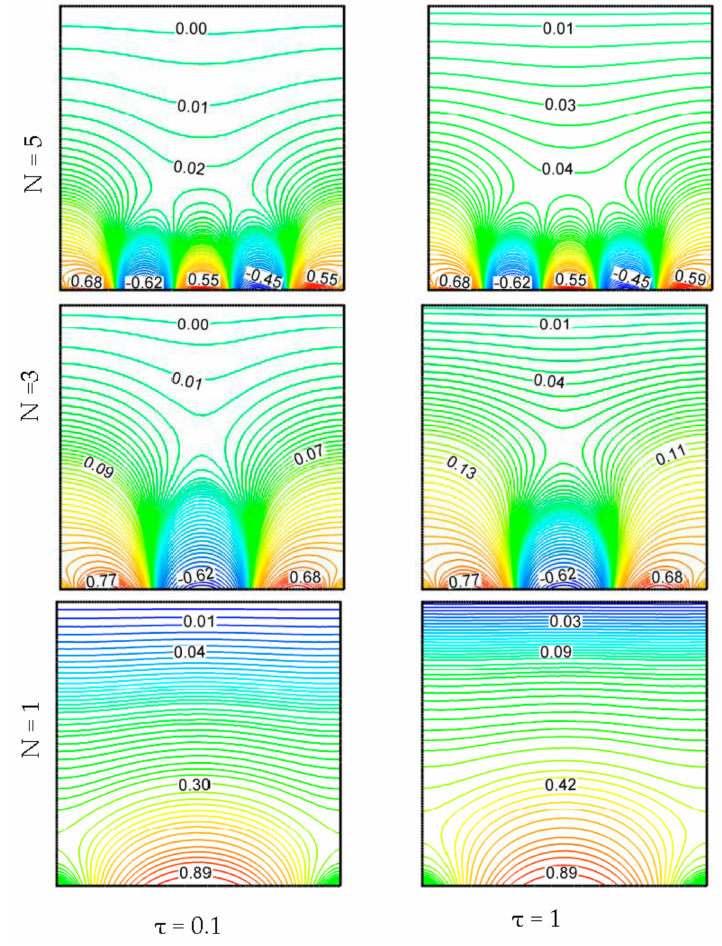
Figure 9. Influence of the odd values of N on isotherms for the selected values of τ with Gr = 10 5 . The results of varying even frequency N (=2, 4, 6) on isotherms for different values of τ (=0.1 and 1) is depicted in Figure 10 for Gr = 10 5 . For N = 2, the isotherms assume a coconut tree leaf shape showing the presence of convective heat transfer in both cases of τ (=0.1 and 1). It can clearly be seen that the isotherm pattern is symmetrical about the mid-vertical plane for the lower value of τ (=0.1), which demonstrates that our explanation held for the argumentation on the streamlines’ distribution. For N = 4, finger print shape isotherms are found to be thickly stacked along the bottom surface and very thickly stacked near the sinusoidal heated bottom wall for N = 6. It gives that the convection is very strong in the bottom heated region. As an outcome, the temperature gradient is lower near the middle part of the top segment of the enclosure for both cases τ = 0.1 and